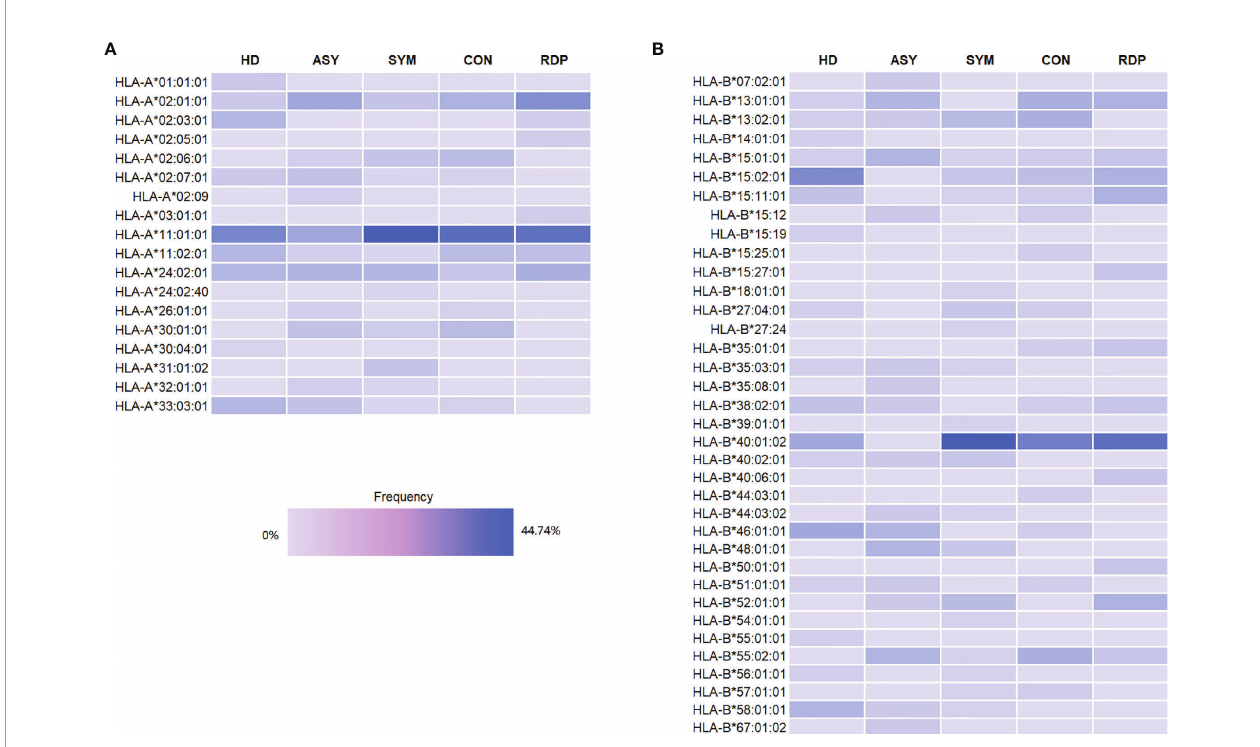
FIGURE 1 | Frequency of HLA-A (A) and HLA-A (B) alleles in different